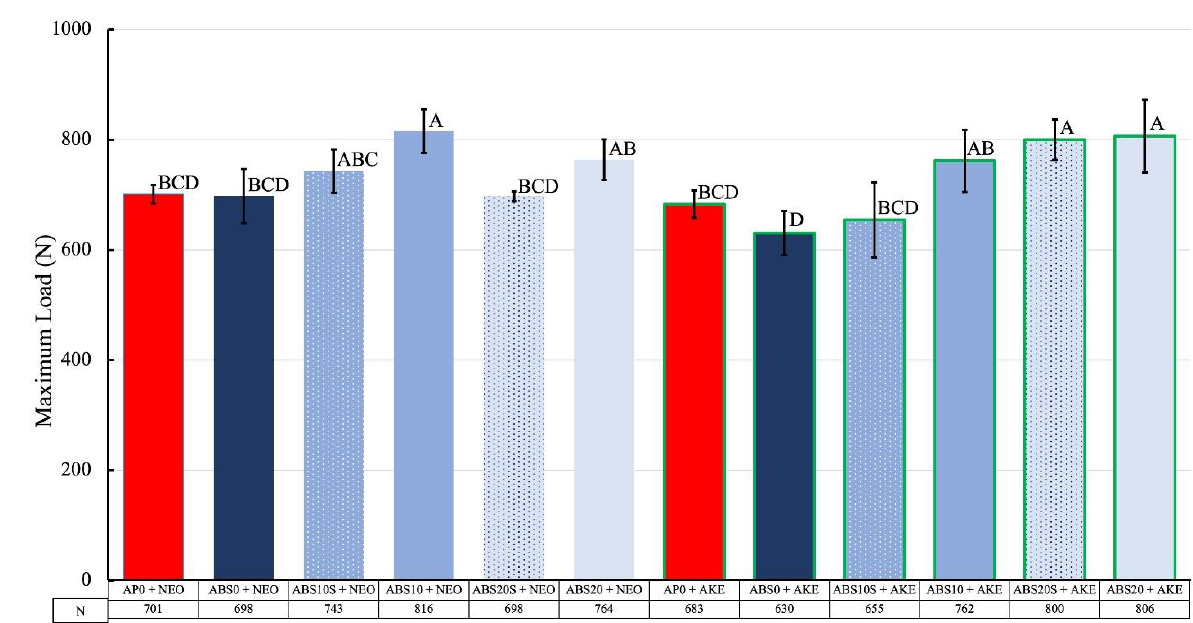
Figure 6. Maximum loads of various specimens obtained from the shock absorption tests. The values of the same letter were not significantly different ( p > 0.05).